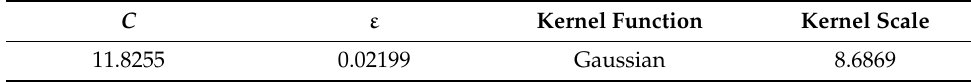
Table 3. List of hyperparameters of the optimized model. C ε